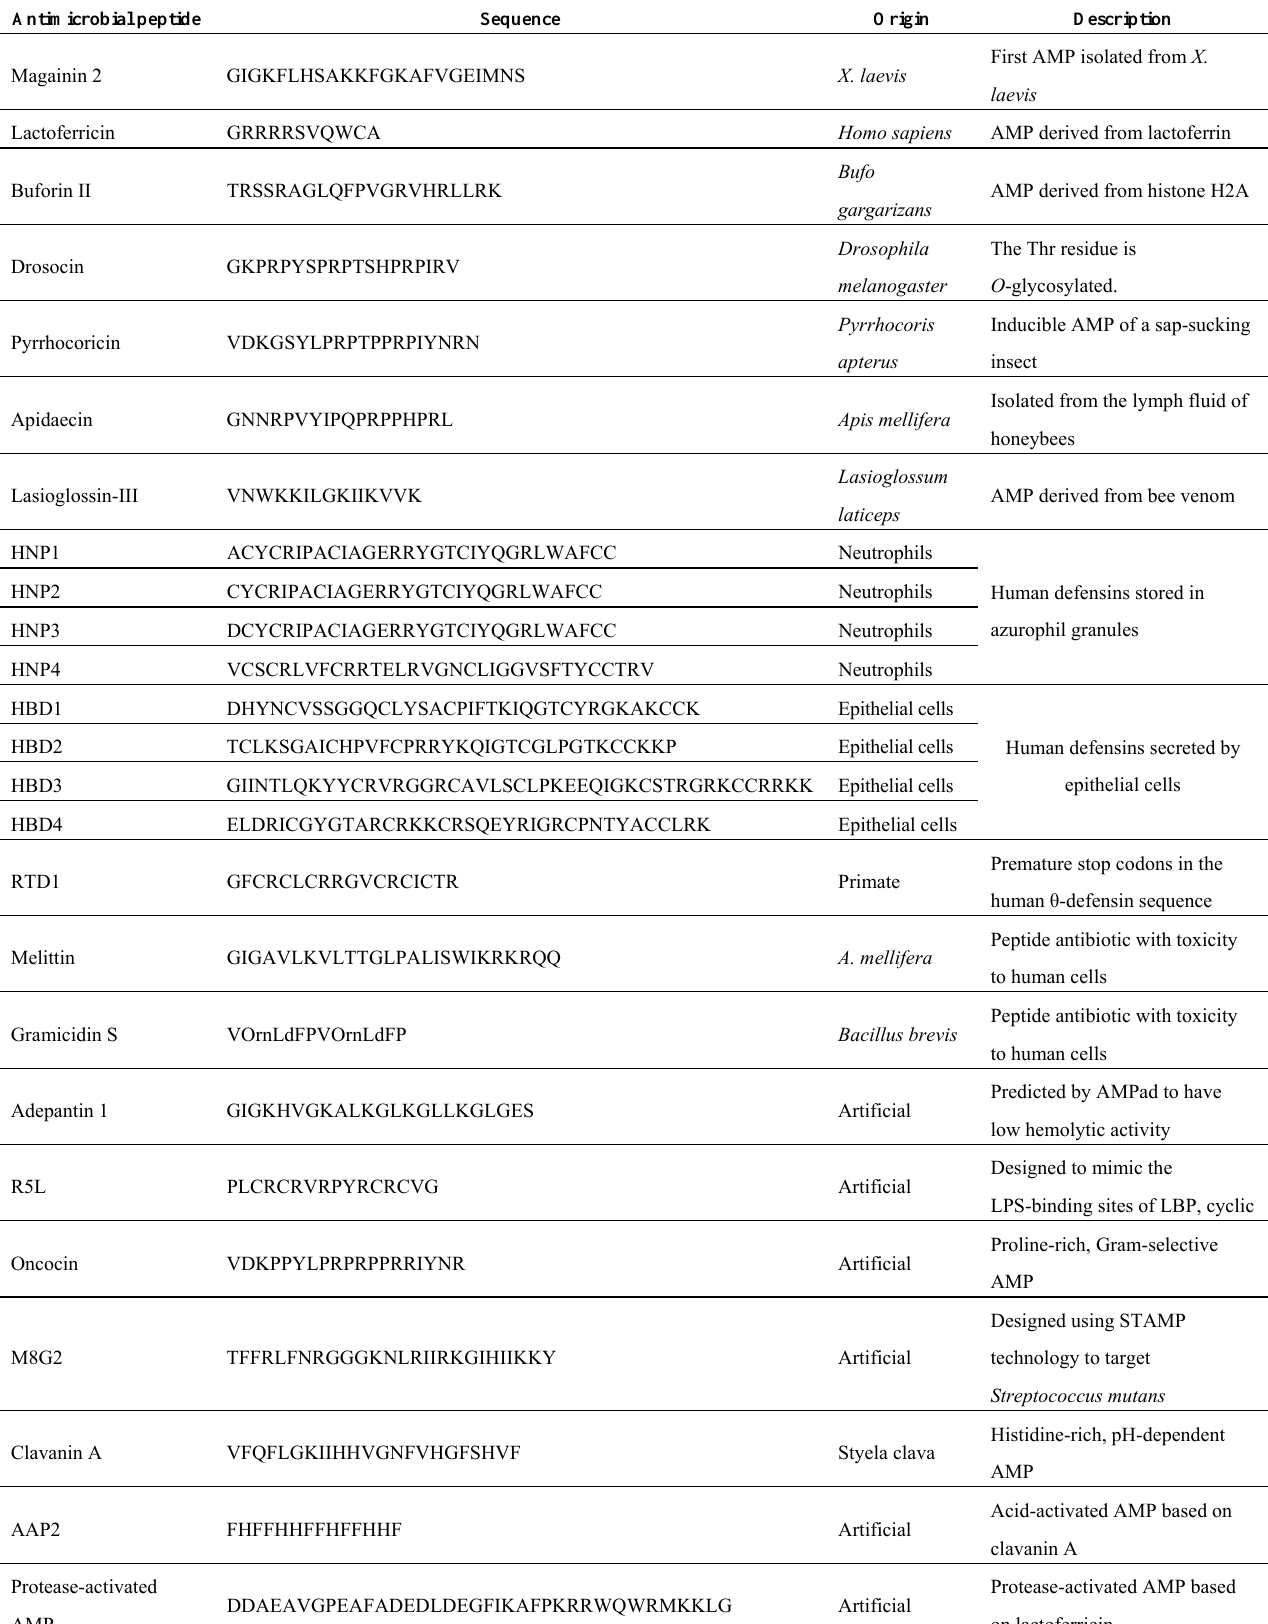
Table 1. Antimicrobial peptides reviewed in this